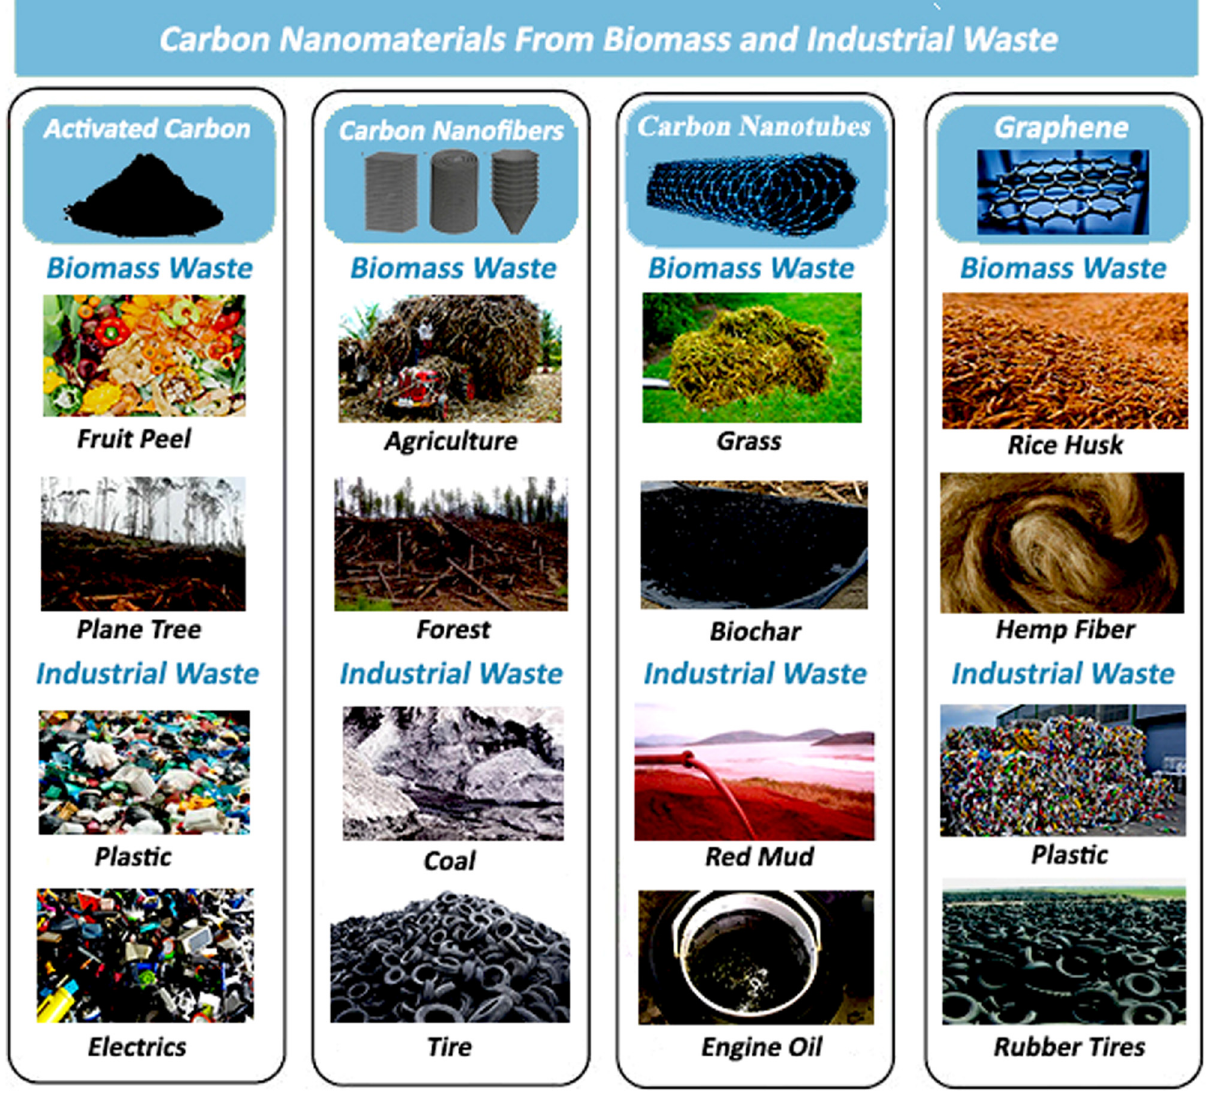
Figure 7: Types of carbon nanomaterial obtained from recycled